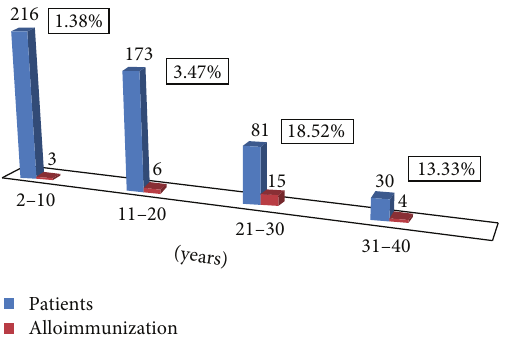
Figure 2: Alloimmunization in different age groups.